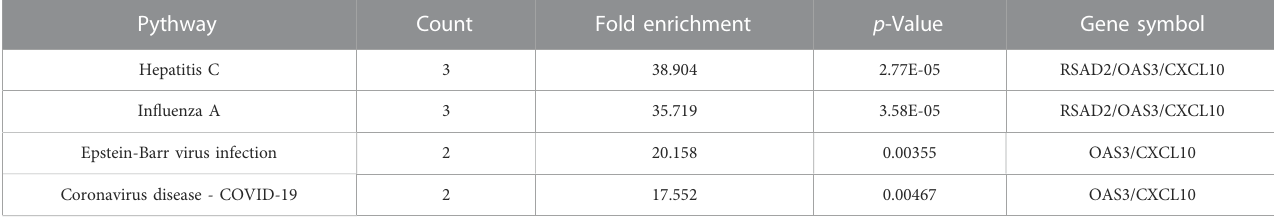
TABLE 2 KEGG pathway analysis of hub